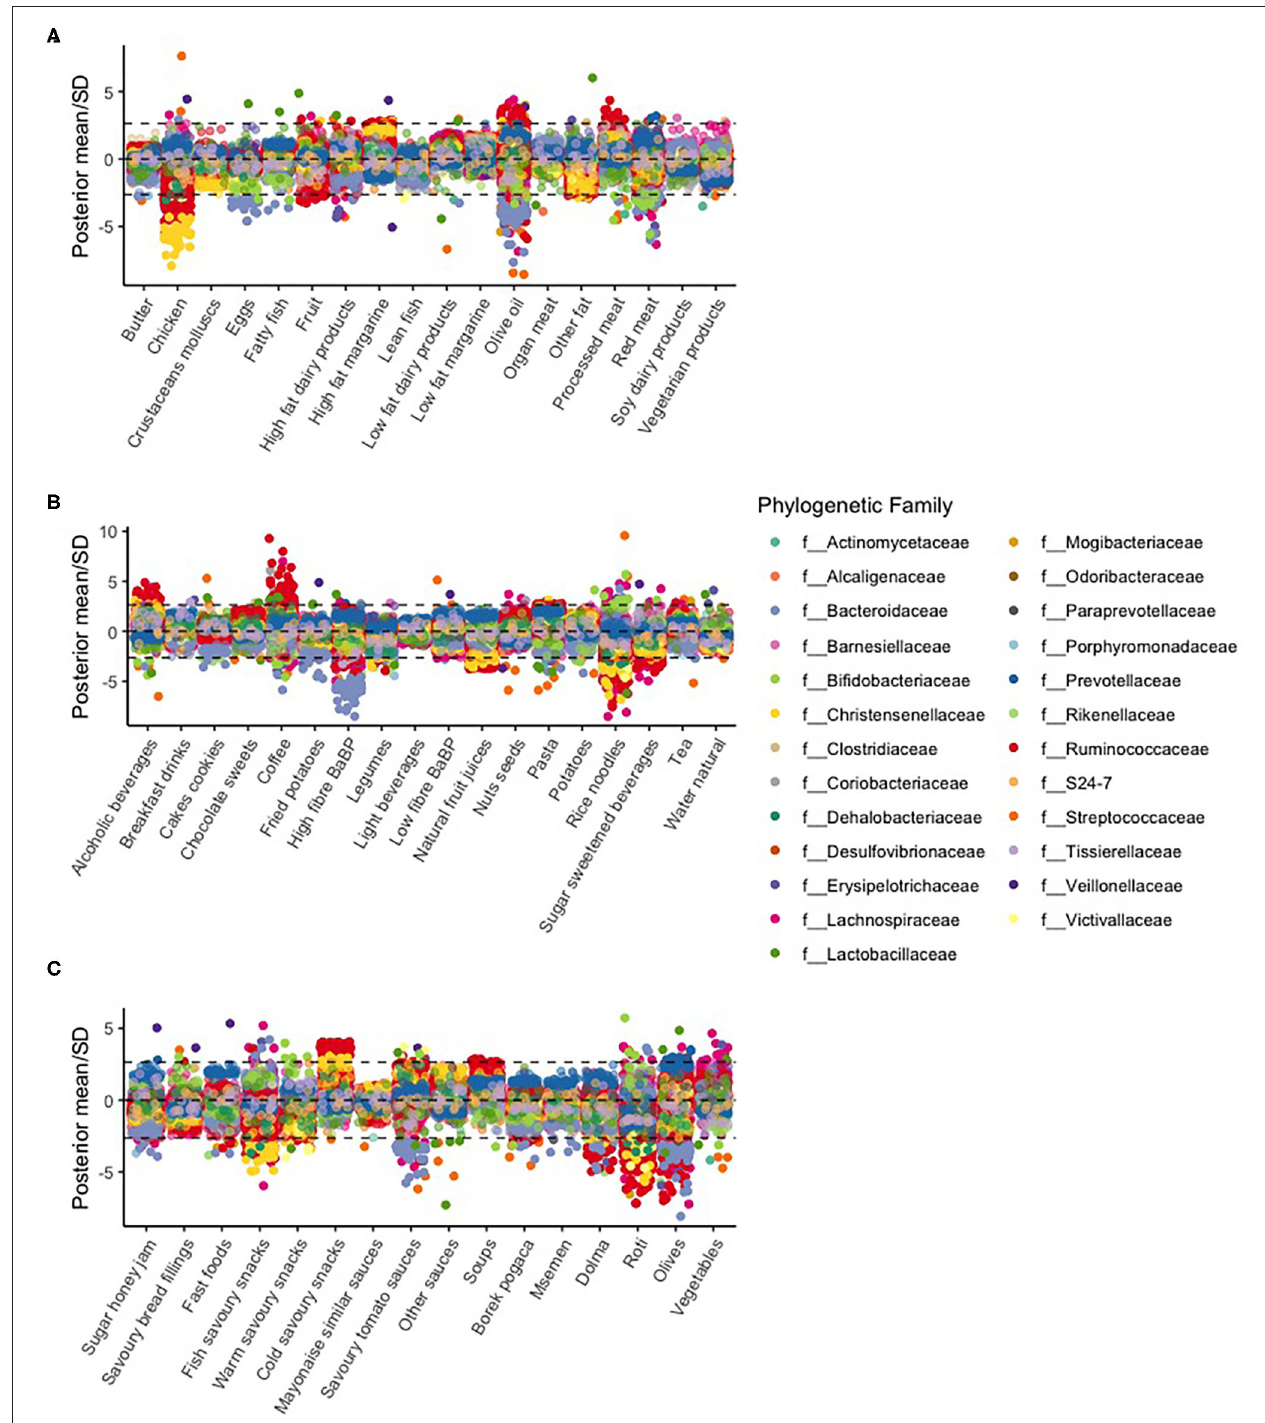
FIGURE 3 | Manhattan plot of various food items [ (A) butter to vegetarian products, (B) alcoholic beverages to water natural, and (C) sugar honey jam to vegetables] and associations per OTU. The dotted lines represent a statistical significance threshold (z-score). Because we had six batches, we used the Bonferroni method as a correction factor for multiple testing. Within the batches, we did not correct for multiple testing because the Bayesian hierarchical model already provides shrunken estimates.